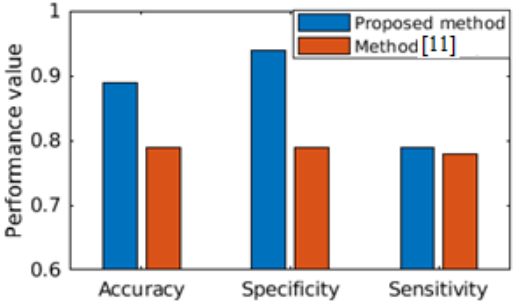
Figure 6. Performance comparison of proposed clinical analytics method of detecting clinical ‘abnormality’ from PCG signals.